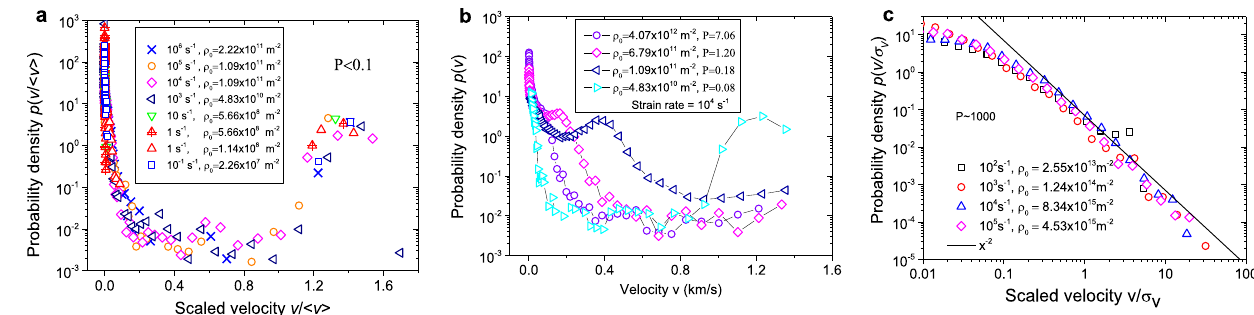
Fig. 7 Probability distributions of dislocation velocities as observed in DDD simulations. a Distributions in the strain rate hardening regime, P < 0.1. b Distributions in the intermediate regime 0.1 < P < 10. c Distributions in the forest hardening regime, P ~ 1000, in double-logarithmic representation, where the full line indicates a slope of − 2. σ v is the standard deviation of dislocation velocity distribution, and v h i is the mean velocity of all dislocations. DDD is abbreviation of discrete dislocation